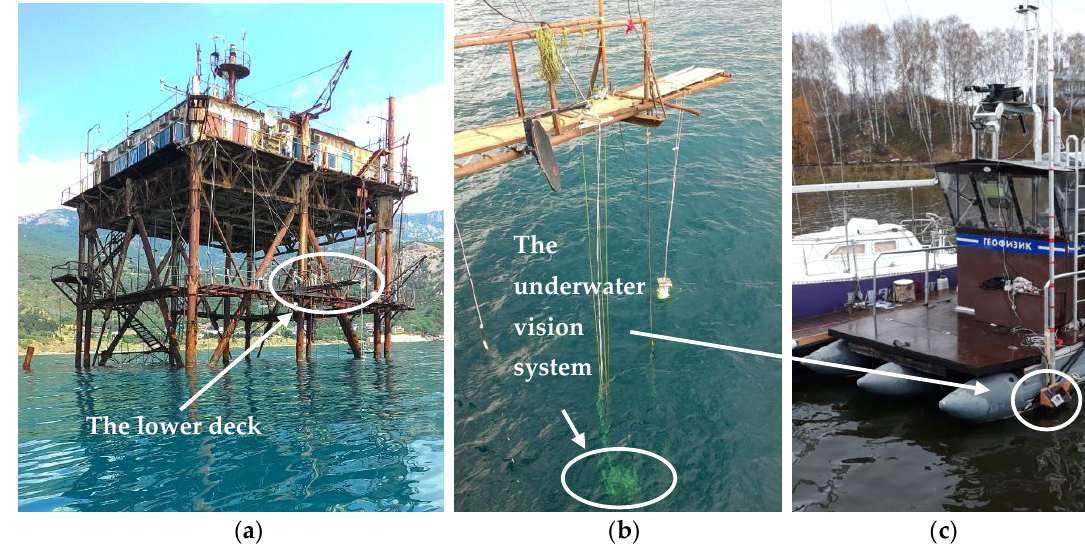
Figure 4. ( a ) The Oceanographic Platform in the Black sea; ( b ) the underwater vision system submerged from the lower deck of the platform; ( c ) the underwater vision system submerged from the scientific vessel in the Gorky Reservoir.